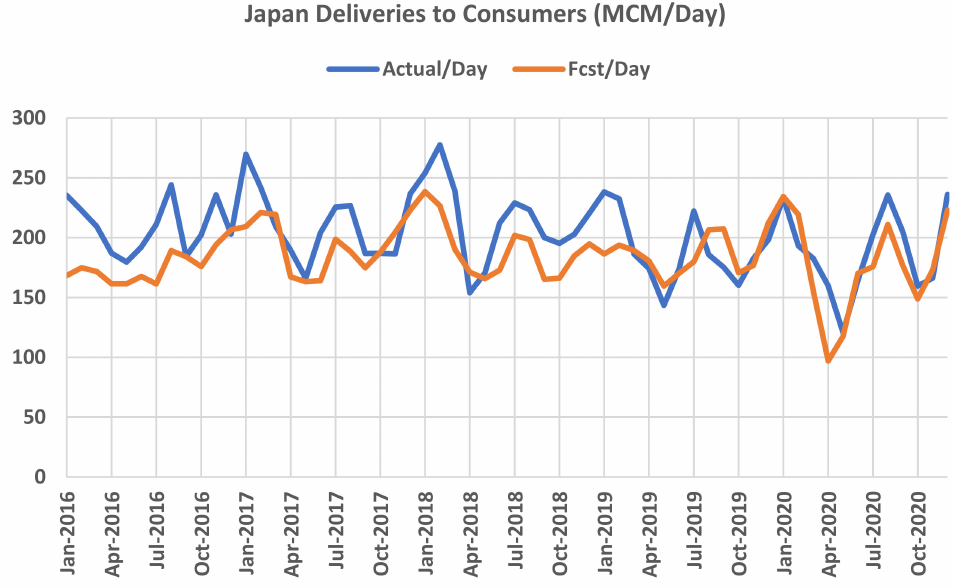
Figure 12. Calibrated gas deliveries versus historical consumption—Japan (unit: million cubic meters per